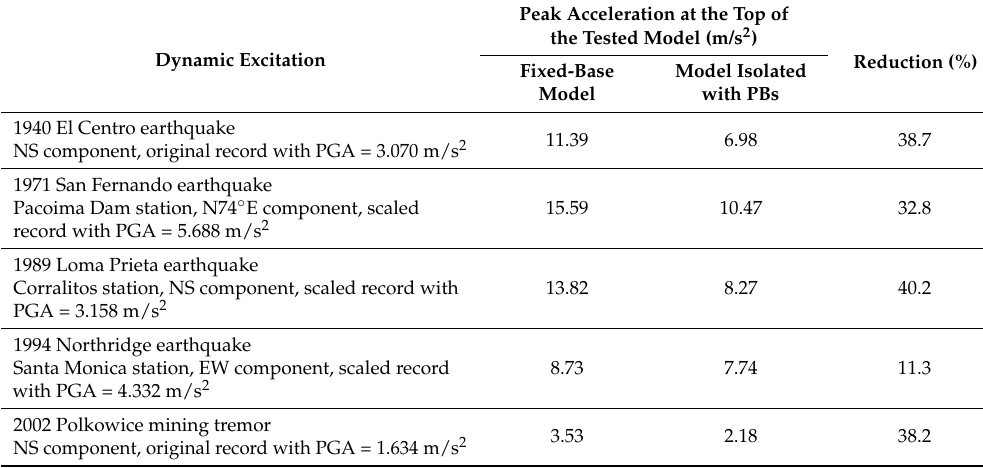
Where: PGA: Peak Ground Acceleration, NS: North-South, EW: